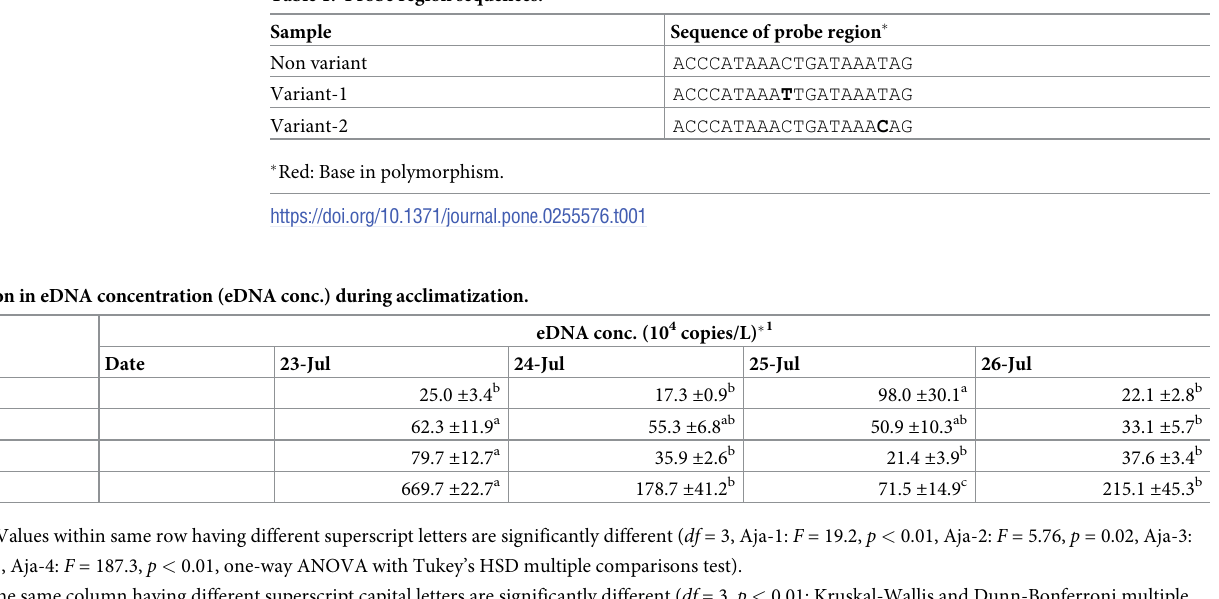
� 1 Average ± SD. Values within same row having different superscript letters are significantly different ( df = 3, Aja-1: F = 19.2, p < 0.01, Aja-2: F = 5.76, p = 0.02, Aja-3: F = 38.7, p < 0.01, Aja-4: F = 187.3, p < 0.01, one-way ANOVA with Tukey’s HSD multiple comparisons test). � 2 Values within the same column having different superscript capital letters are significantly different ( df = 3, p < 0.01; Kruskal-Wallis and Dunn-Bonferroni multiple comparisons